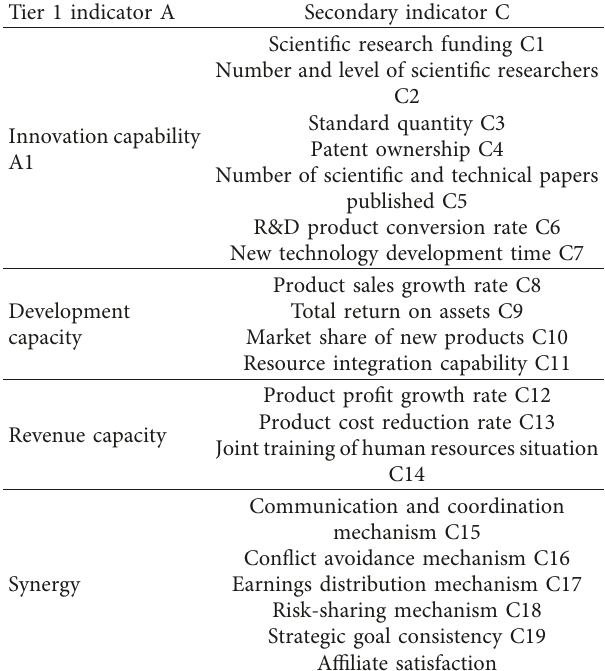
Table 1: Evaluation